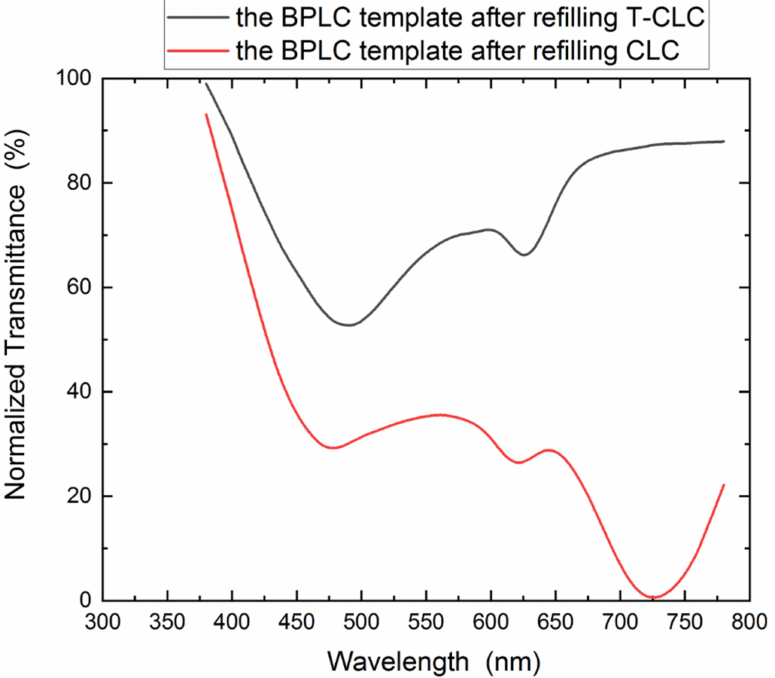
Figure 8. Transmittance spectra of the blue phase template after the first refill and the second